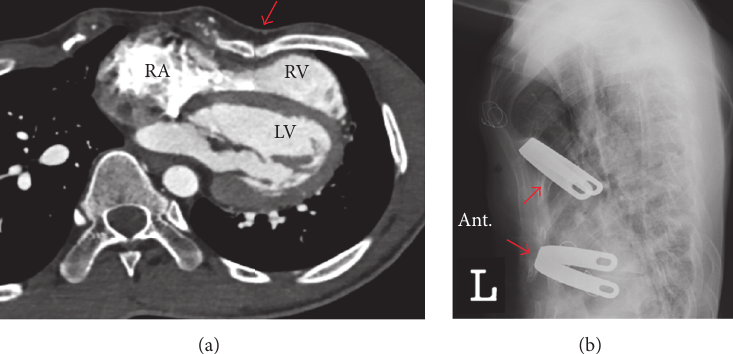
Figure 3: (a) Cross-sectional computed tomography image shows external compression (red arrow) on the basal-to-mid portion of the right ventricle (RV) and dilation of the right atrium and RV apical site (Haller index 5.21). (b) A lateral view of the chest X-ray after Nuss operation shows that anterior chest wall is decompressed by two Nuss bars underneath the sternum (red arrows) across the chest. RA, right atrium; RV, right ventricle; LV, left ventricle; ant.,